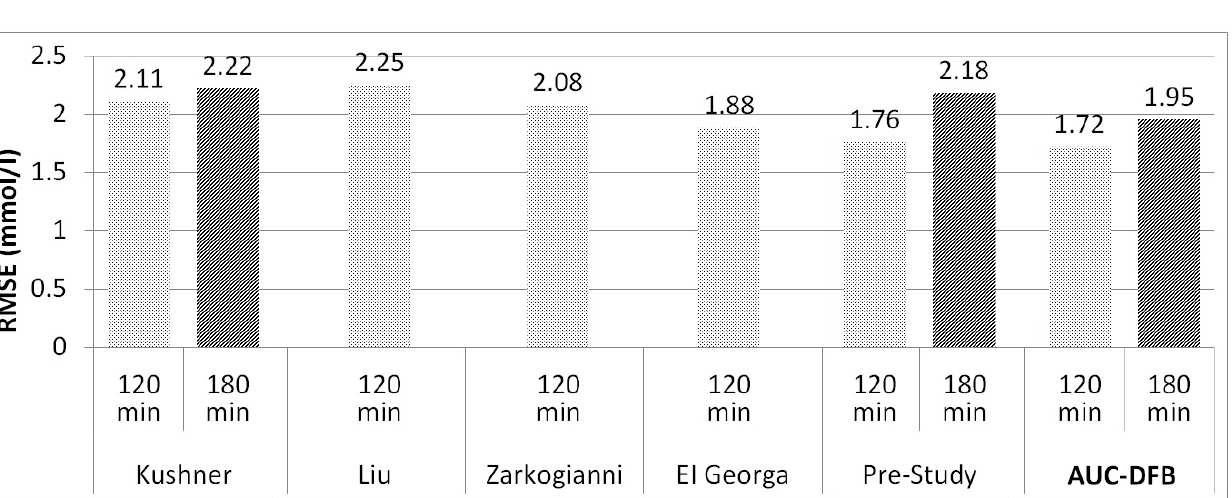
Figure 5. RMSE results on the 120 and 180 min PHs, comparison of related work, and the pre-study to current work (AUC-DFB). The 180 min results are not available for all studies. The 120 min result of Mathiyazhagan of 5.71 mmol/L was not included in the figure to preserve a readable vertical scaling of the chart. All values are in mmol/L.